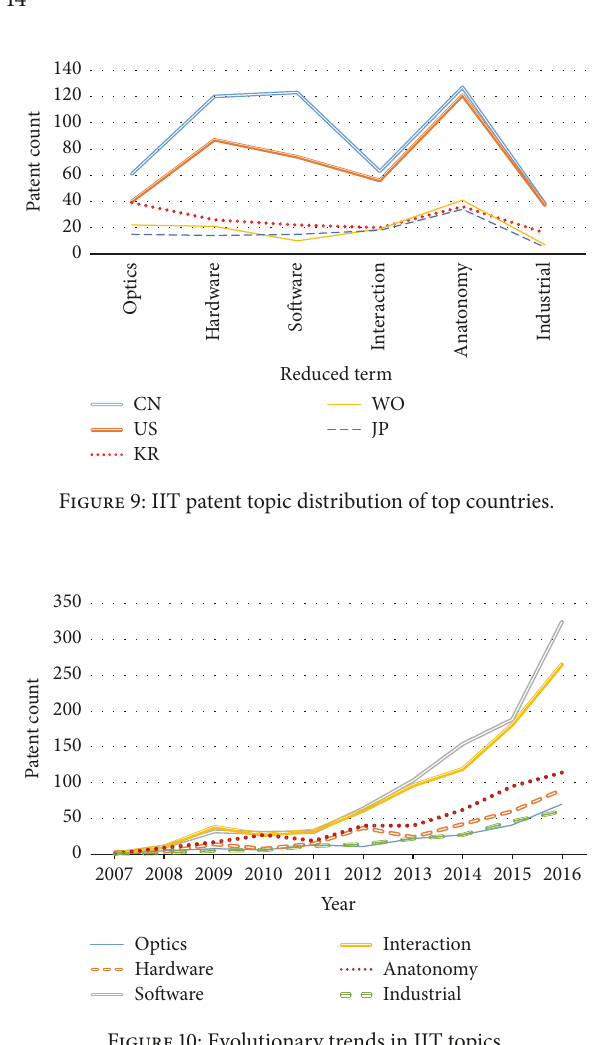
Figure 10: Evolutionary trends in IIT